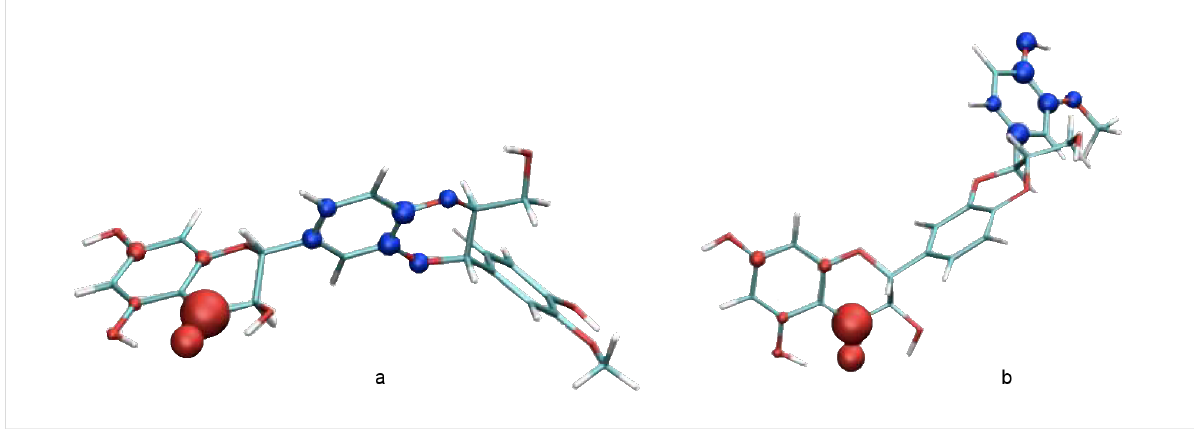
Figure 7: Spatial distribution of nucleophilic f − (r) (blue) and electrophilic f +(r) (blue) Fukui functions of silybin A ( 1a ) in both a) EtOAc and b) DMF.